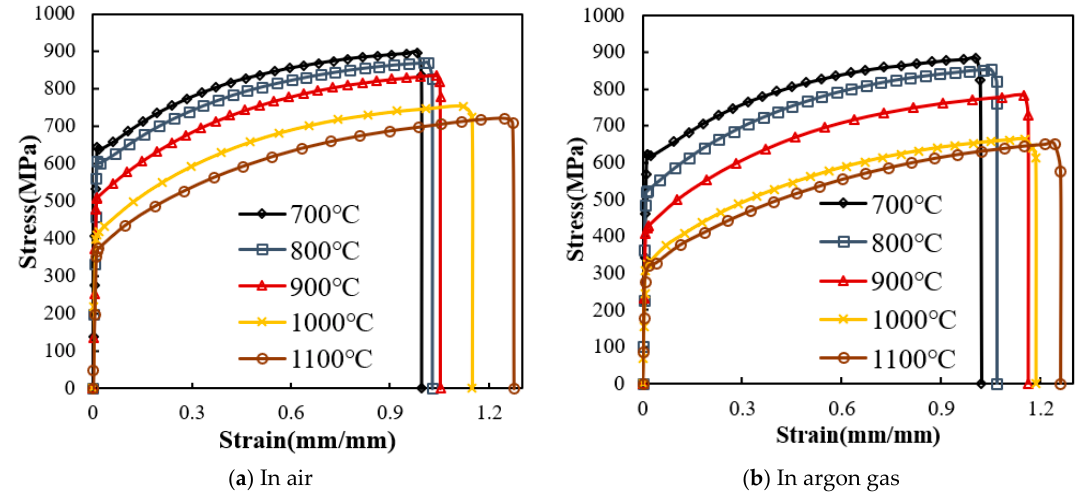
Figure 5. Engineering stress-strain curves at different forming temperatures.